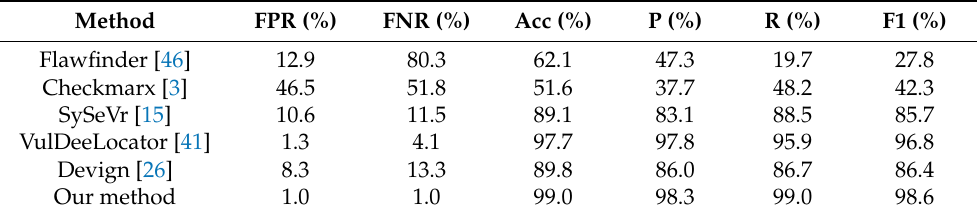
Table 5. Results for RQ3. Comparative